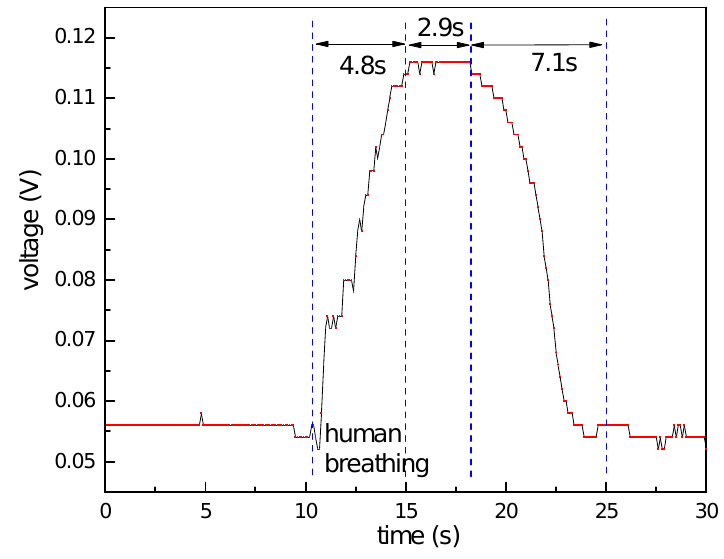
Figure 8. The voltage response of the sensor coated by 0.1 wt/vol % agarose